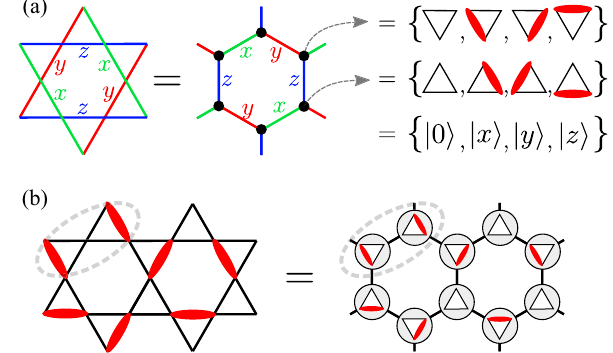
FIG. 2. Emergent dimer model on the kagom´e lattice as a spin- 3 = 2 model on the honeycomb lattice. (a) Each triangle of the kagom´e lattice is effectively a four-level state as shown, making a kagom´e lattice dimer model into a spin- 3 = 2 model on the honeycomb lattice. Labeling the three different types of bonds of the honeycomb lattice as x , y , z [29] also induces a labeling on the kagom´e lattice as shown. Correspondingly, we can label the basis states according to whether the dimer occupies the x , y , z bond of the kagom´e lattice. (b) An example of how a dimer state on the kagom´e lattice is encoded in a spin- 3 = 2 state on the honeycomb lattice. This tensor-product Hilbert space not only contains all dimer coverings but also defects: The dashed line highlights a monomer ( e -anyon) excitation (i.e., a vertex not touched by a dimer). Directionally dependent two-body inter- actions energetically penalize such configurations to obtain the emergent dimer constraint in Eq. (6) (see also Fig.